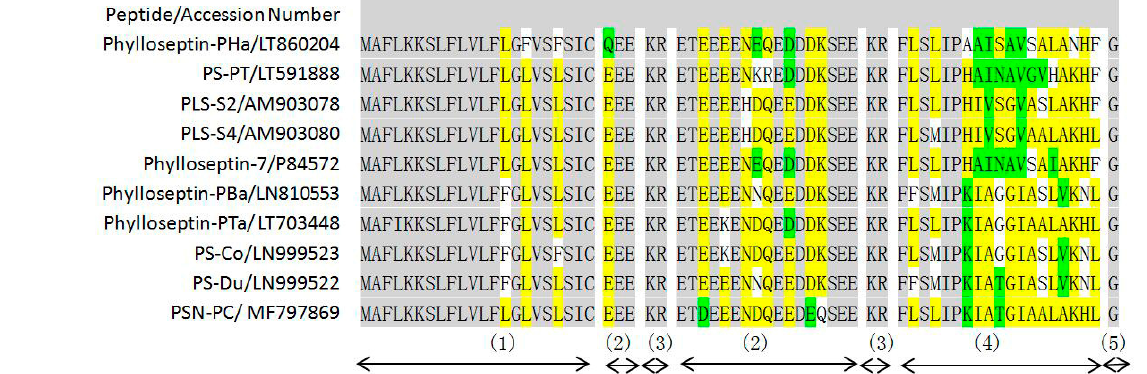
Figure 2. Multiple alignments of the cloned cDNA-deduced amino acid sequence of phylloseptins with antimicrobial activities. Grey shading indicates identical amino acid residues, yellow shading indicates consensus amino acid residues, and green shading indicates similar amino acid residues. (1): putative